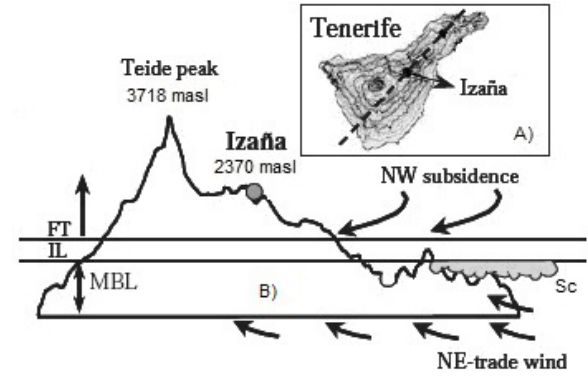
Fig. 1. (A) Location of Iza˜na in Tenerife Island, (B) transect of Tenerife Island – along the dotted line in (A) – showing the vertical stratification: MBL: marine boundary layer, IL: inversion layer, FT: free troposphere, Sc: